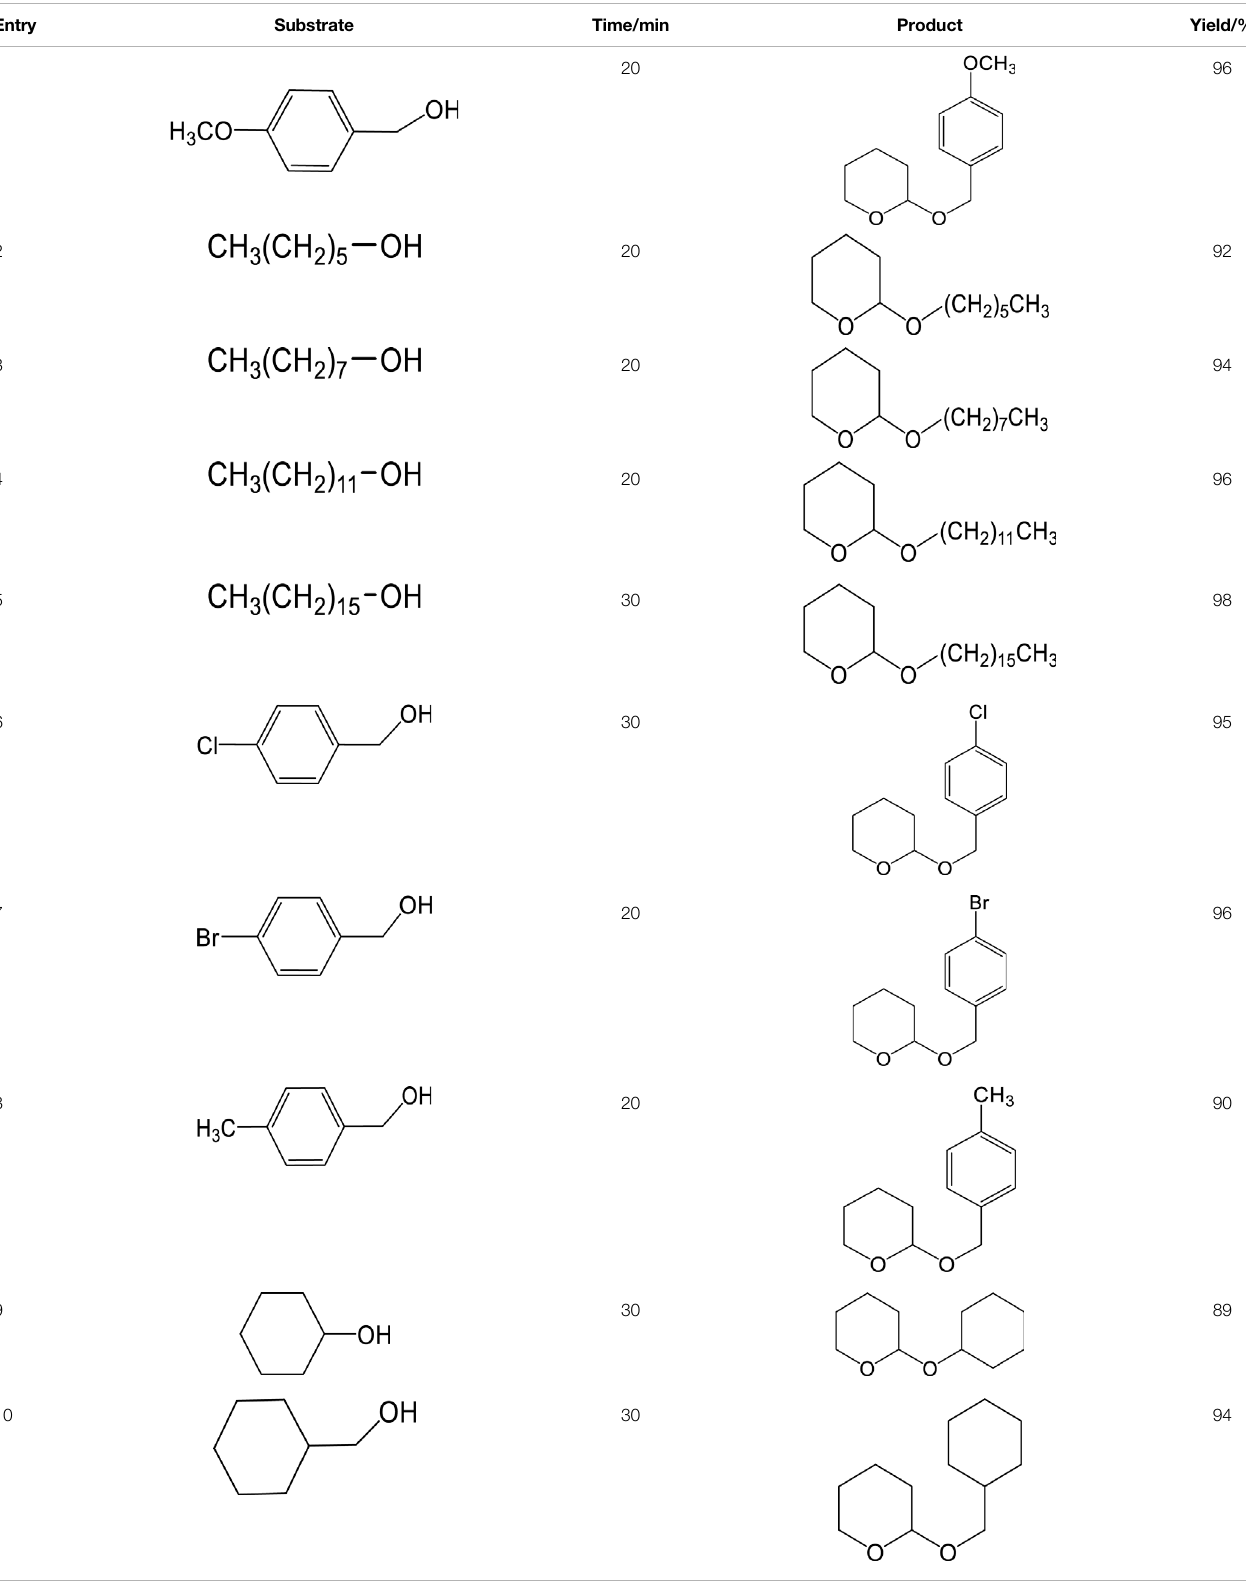
TABLE 3 | Catalytic effects of different alcohols under the action of 3D SiO 2 -NH-SO 3